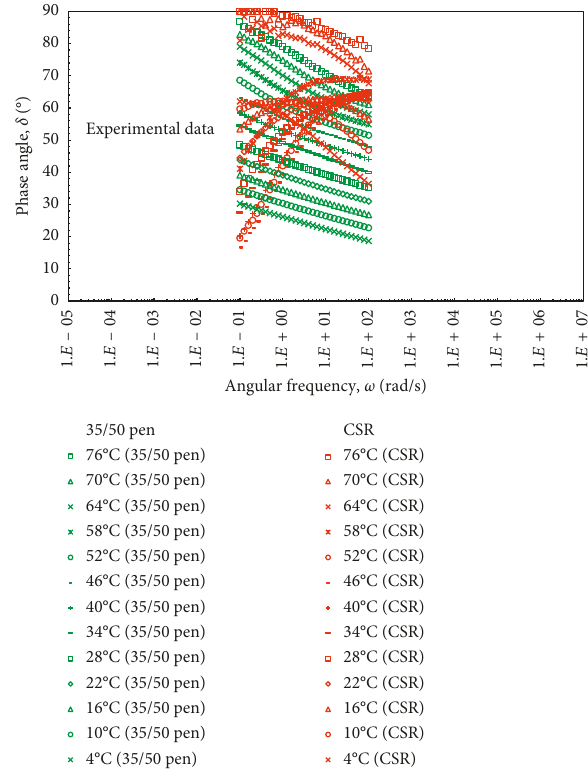
Figure 19: Experimental results of phase angle ( δ vs. ω )—35/50 pen vs.